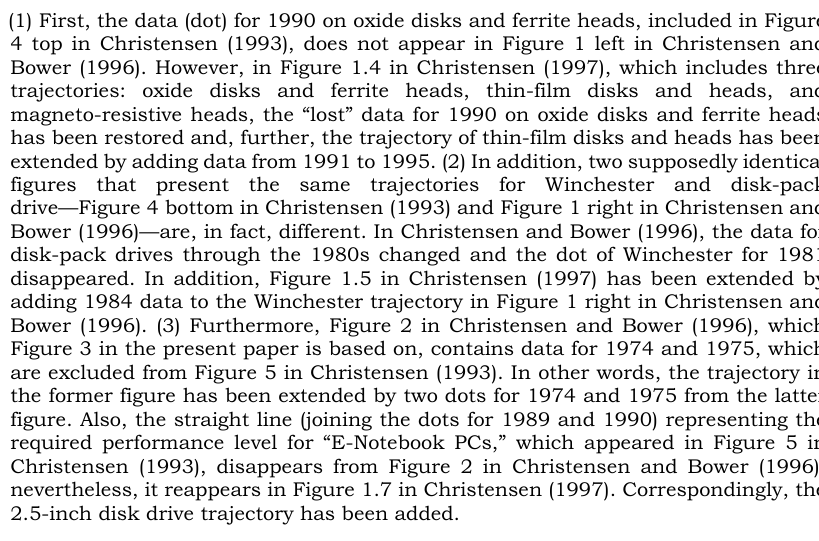
(mainframes, minicomputers,